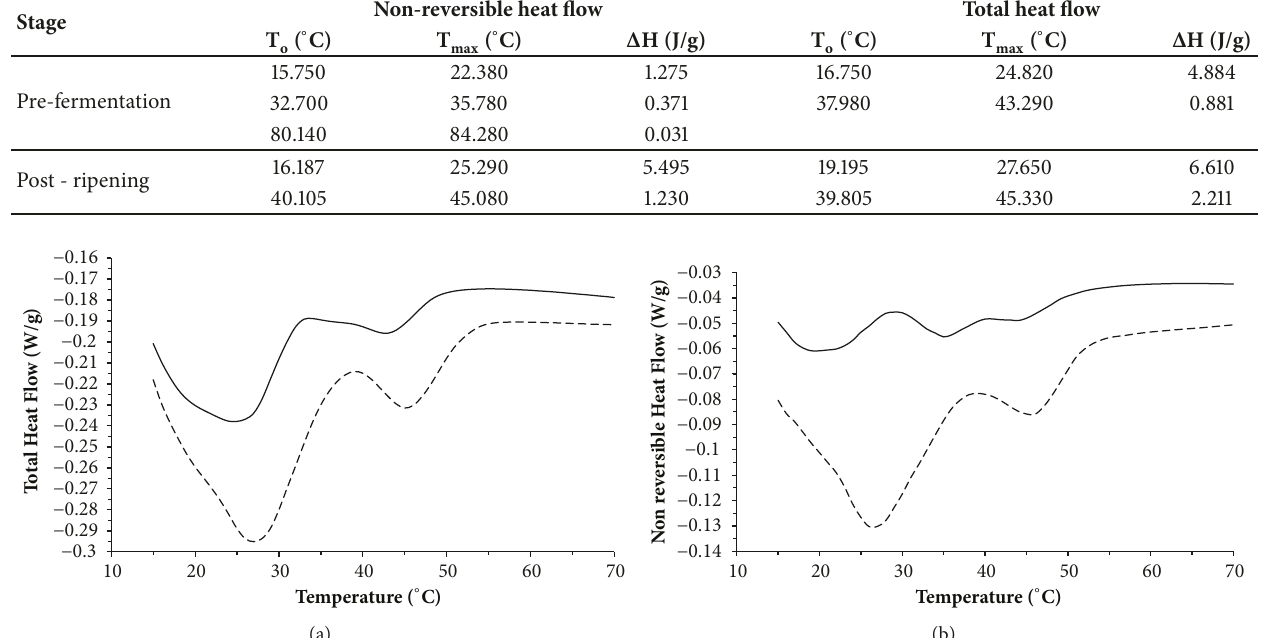
Figure 1: Modulated Differential Scanning Calorimetry (MDSC) curves indicating exothermic/endothermic total heat flow (a) and nonreversible heat flow (b) for salami lipid fraction in prefermentation stage (–) and postripening stage (-